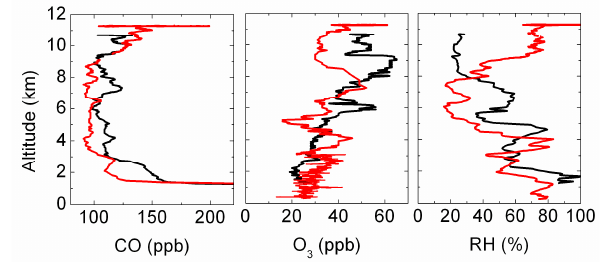
Fig. 4: Vertical profiles of CO, O 3 and RH used as convection indicators. Fig. 4. Vertical profiles of CO, O 3 and RH used as convection in- Black lines (August 13 th flight) are typical variation in non-convective conditions. Red lines dicators. Black lines (13 August flight) are typical variation in non- (August 14 th flight) are the vertical variations in convective conditions. convective conditions. Red lines (14 August flight) are the vertical variations in convective conditions.